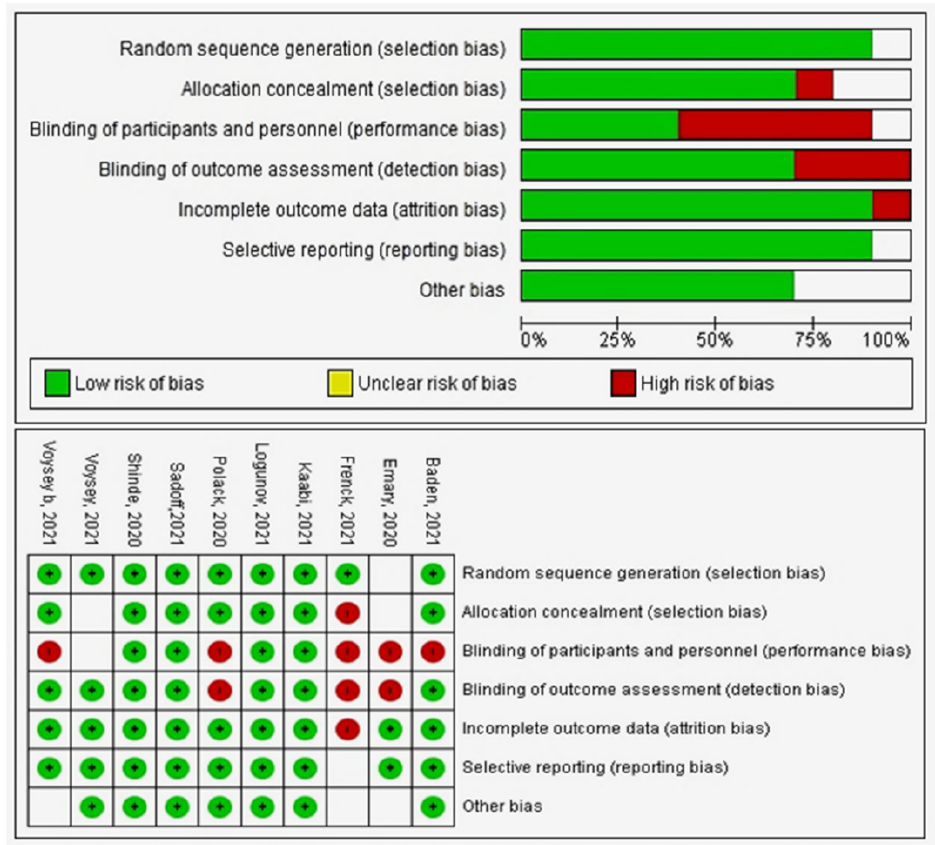
Figure 3. Quality assessment of RCT